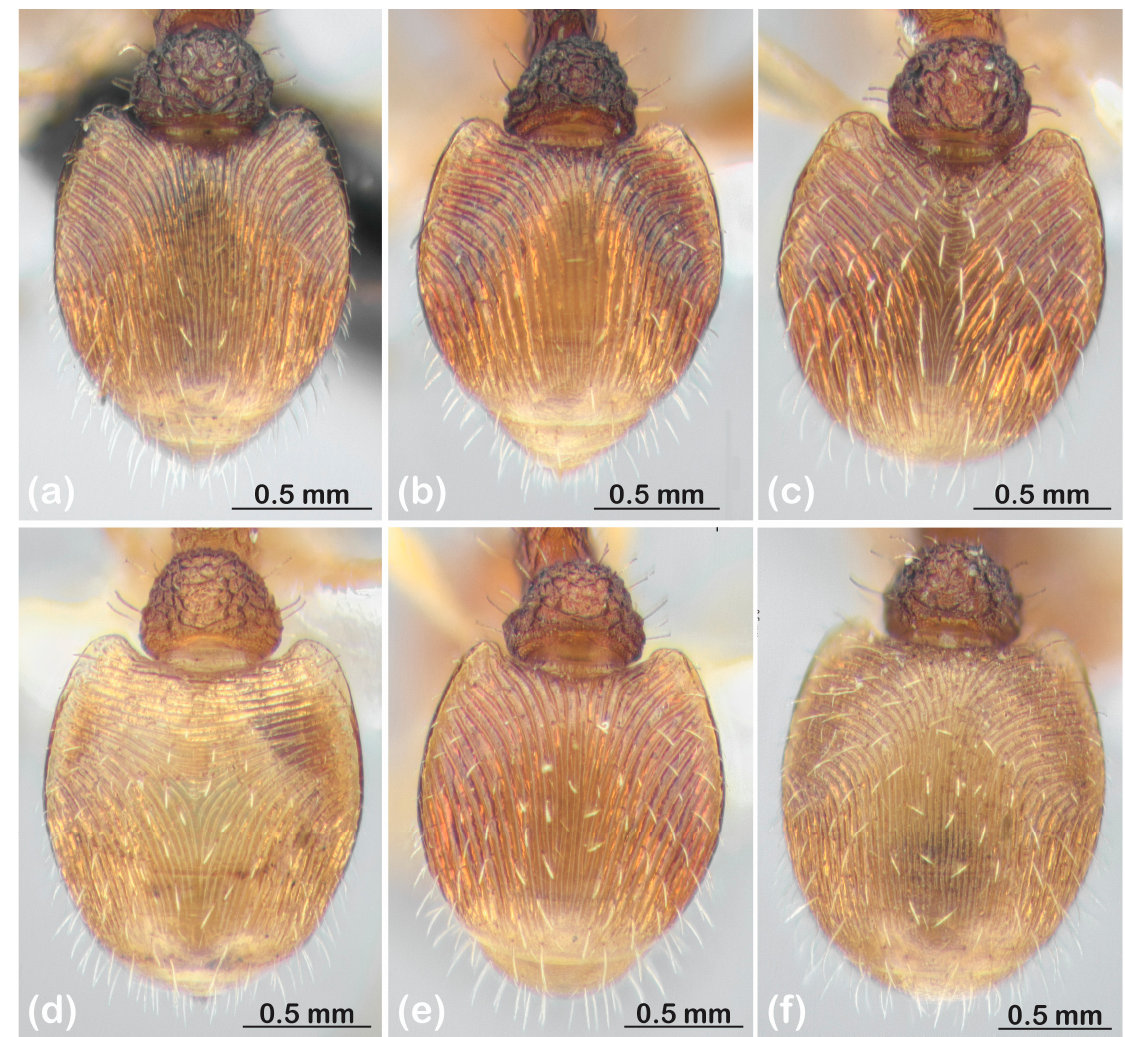
Figure 8. Variation in coarse gastral sculpture of six species ( a – f ) of the T. spininode group from the Kimberley region of